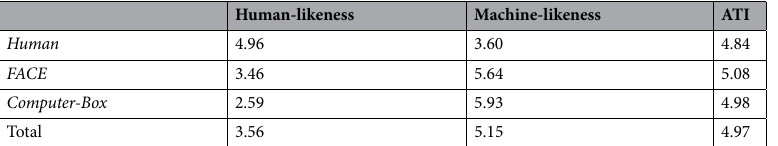
Table 3. Participants’ perception and technological affinity. For each type of player-B, this table reports the average values of variables measuring on a scale from 0 to 7 human-likeness, machine-likeness and technological affinity (ATI scale as in 35